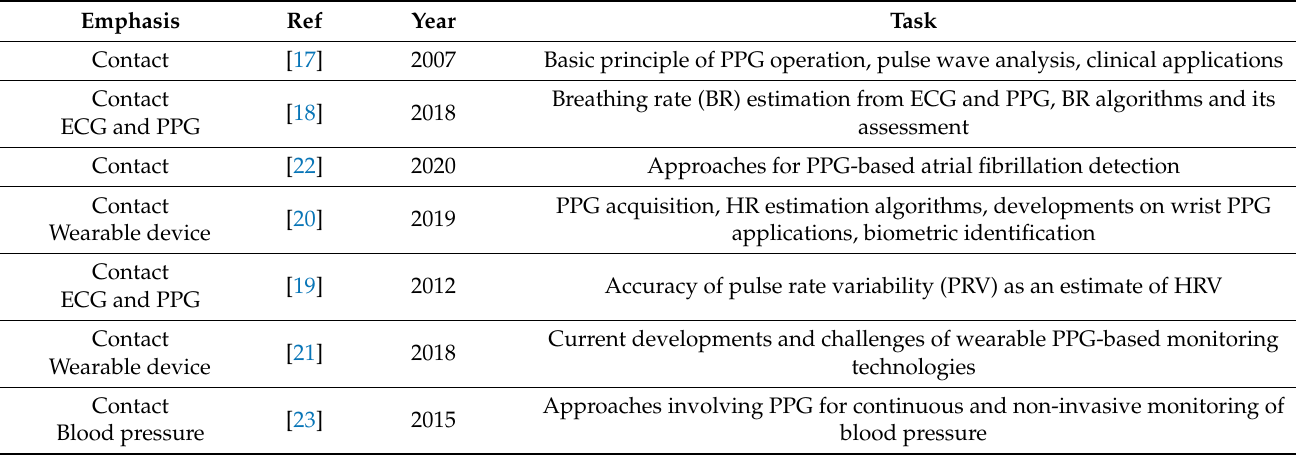
Table 1. Previous survey papers on contact-based PPG methods.